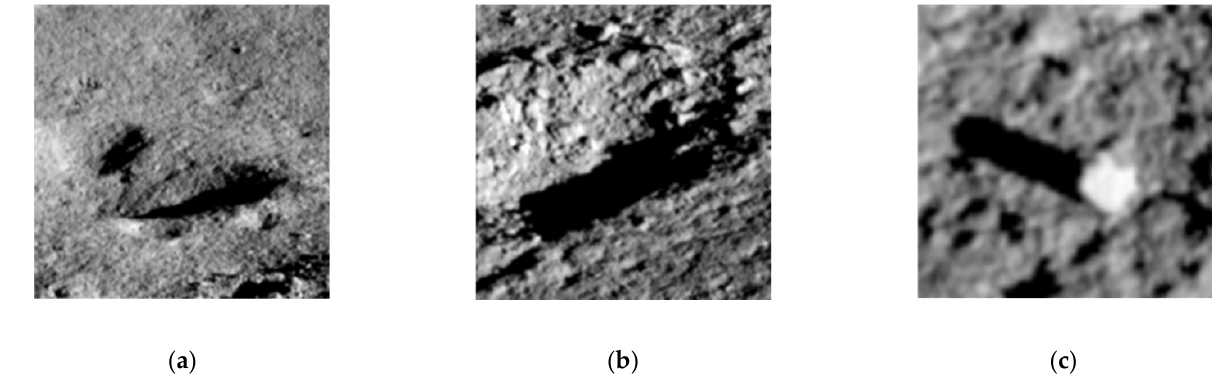
Figure 12. Examples of shadows ( a ) shadow inside two craters, ( b ) shadow inside a crater, ( c ) shadow behind a boulder.